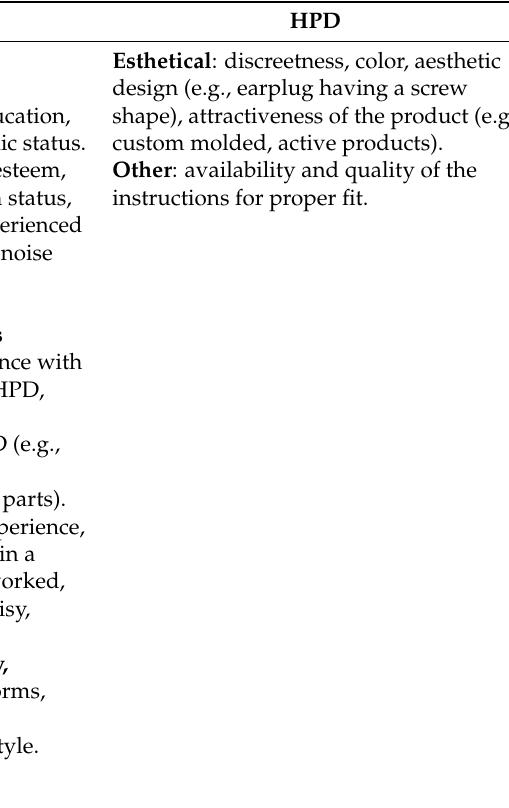
Table 5. Psychosocial characteristics of the triad